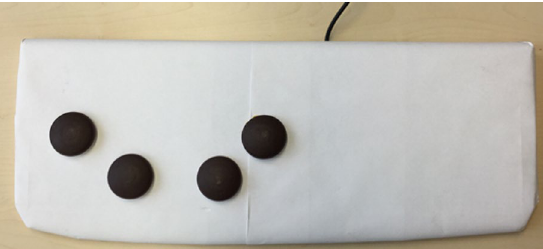
Figure 1. Keyboard device with four buttons used for shock administrations. In Study 4, only a single button was attached to the